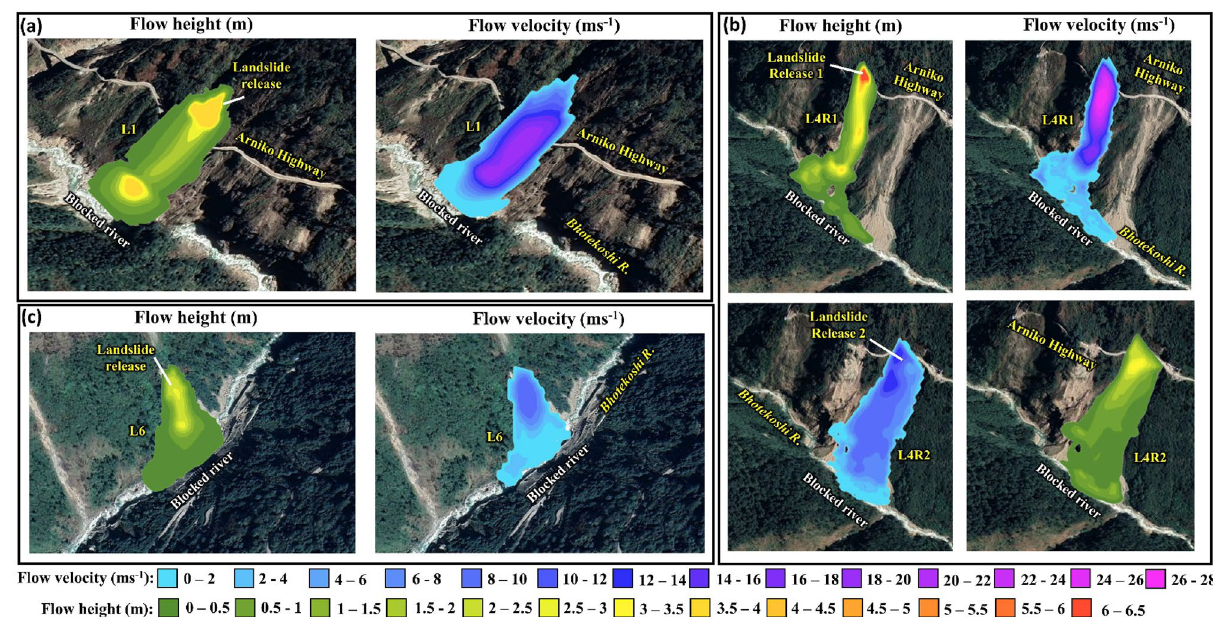
Figure 12. Spatially distributed flow depth (m) and flow velocity (m s −1 ) of the GLOF-induced landslides ( a ) L1; ( b ) L4; and ( c ) L6; Background: imageries from Google Earth (©CNES/Airbus Maxar